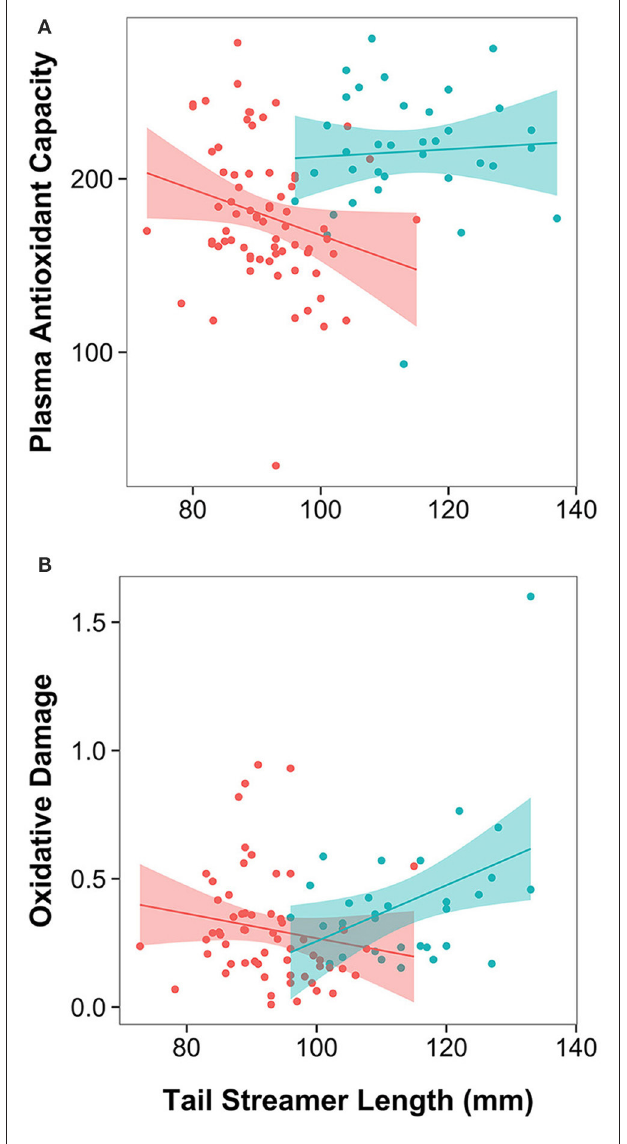
FIGURE 3 | Plumage brightness is oppositely related to plasma oxidative damage in male and female barn swallows: (A) Darker males (those with lower plumage brightness scores) have higher plasma oxidative damage (mM H 2 O 2 equivalents) across both populations, (B) Darker females have lower oxidative damage. Simple regressions shown, with H. r. erythrogaster in red and H. r. rustica in blue. Shading represents the 95% confidence interval for the linear